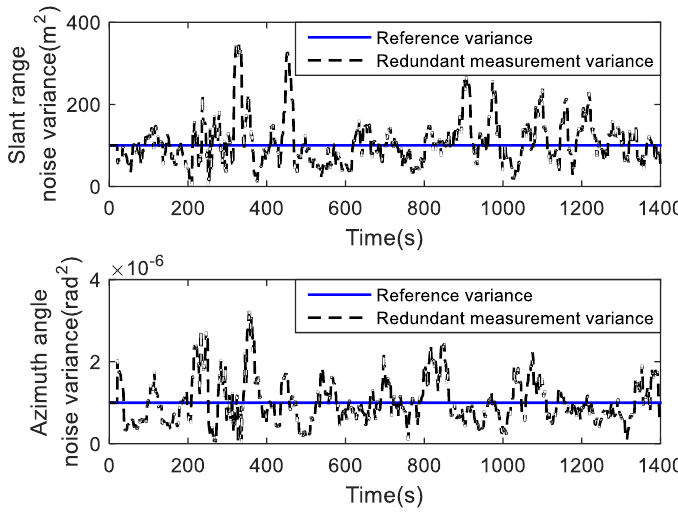
Figure 6. Estimated redundant measurement noise variance for Case 2.